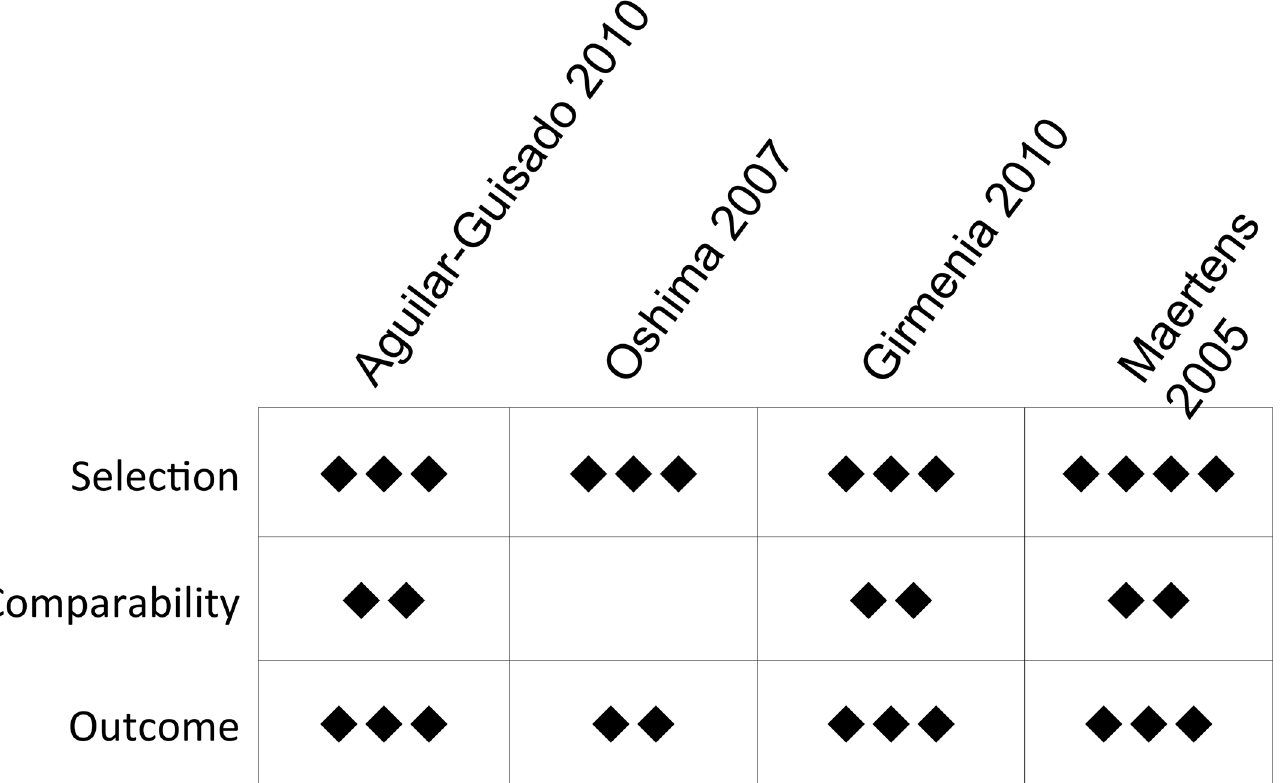
Fig 4. Risk of bias in non-randomized studies as assessed by the Newcastle-Ottawa